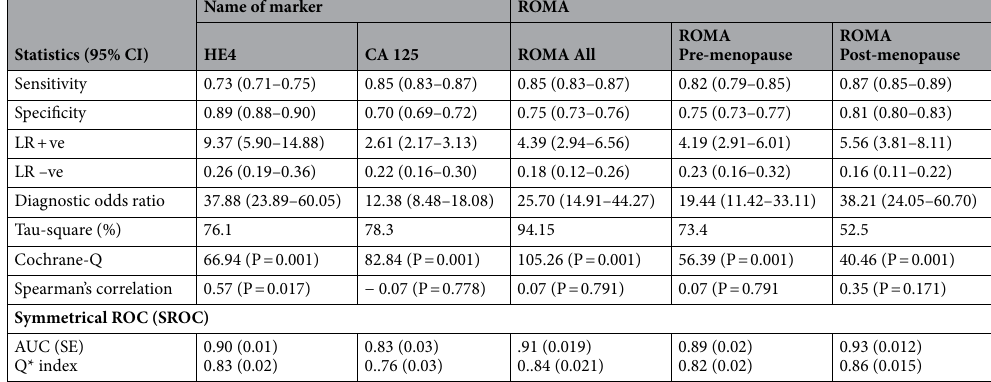
Table 5. Results of sensitivity analysis based on blinded studies using Random effect model. Human epididymis secretory protein 4 (HE4), Cancer antigen (CA125) and Risk of Ovarian Malignancy Algorithm (ROMA). Positive Likelihood ratio (LR + ve), Negative Likelihood ratio (LR–ve), Standard error (SE), Receiver operating characteristic curve (ROC), Area under curve